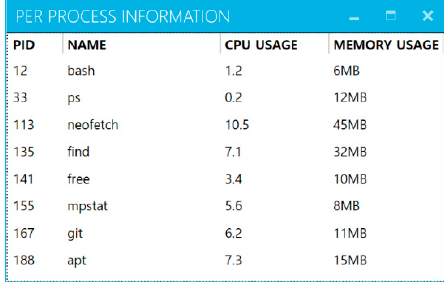
Figure 12. Schematic diagram of the cloud server [14].